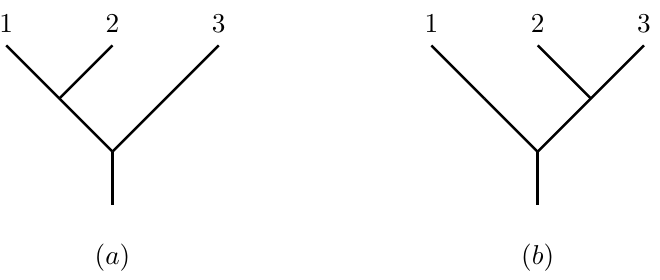
Figure 1 . Binary representations for Lie monomials. ( a ) is the diagrammatic representation for [[1,2],3] and ( b ) represents the Lie algebra structure for [1,[2,3]]. expansion ansatz (3.3) as “power series” of the structure constant f Lie